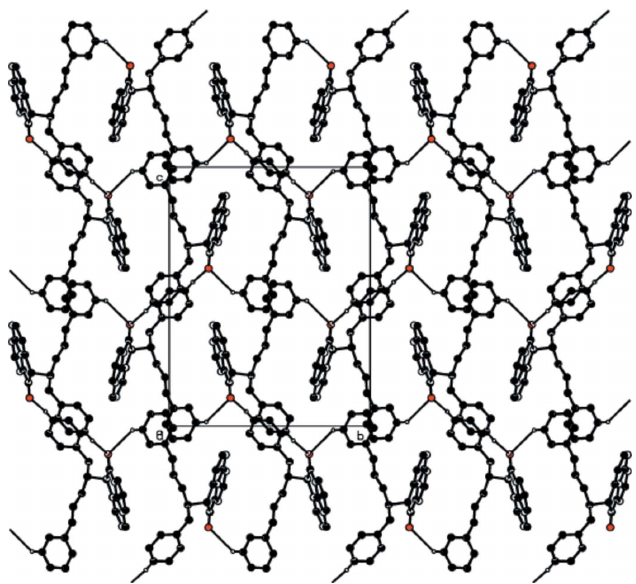
Figure 6 A view of the crystal structure of (I) showing the formation of R 2 graph-set motifs leading to the formation of layers formed parallel to the bc plane. Dashed lines indicate weak C—H (cid:2)(cid:2)(cid:2) O intermolecular inter- actions. H atoms not involved in the interactions have been omitted for